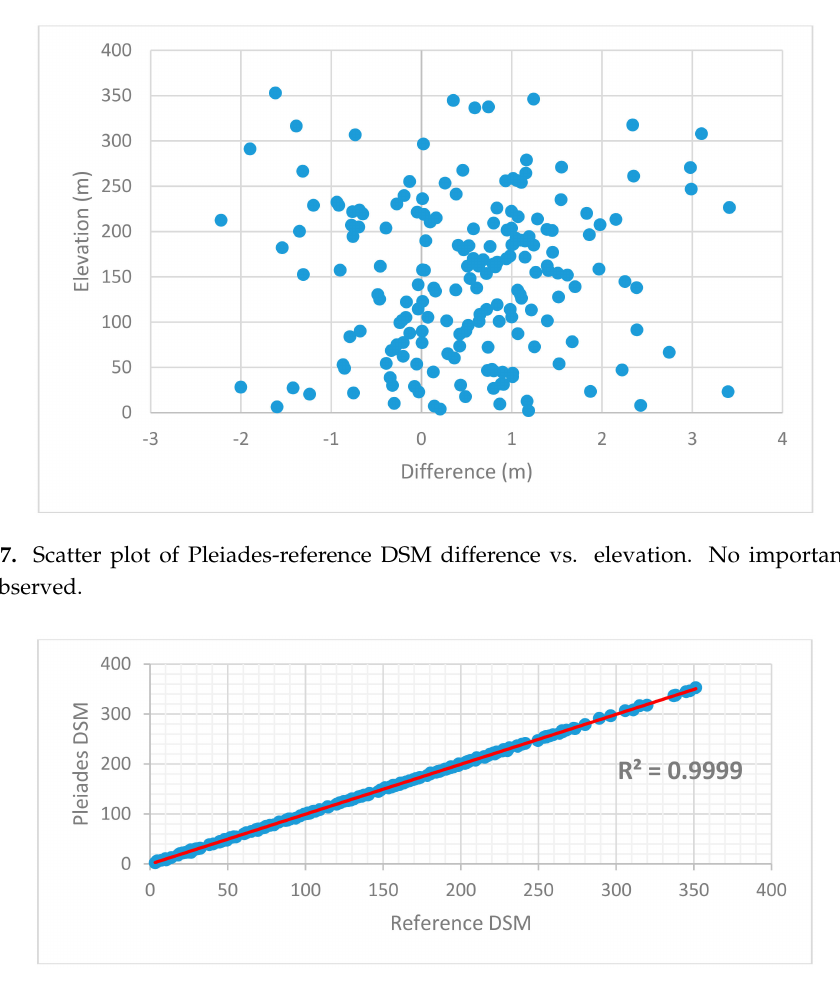
Figure 8. Scatter plot of Pleiades DSM vs. he reference DSM for the 188 random